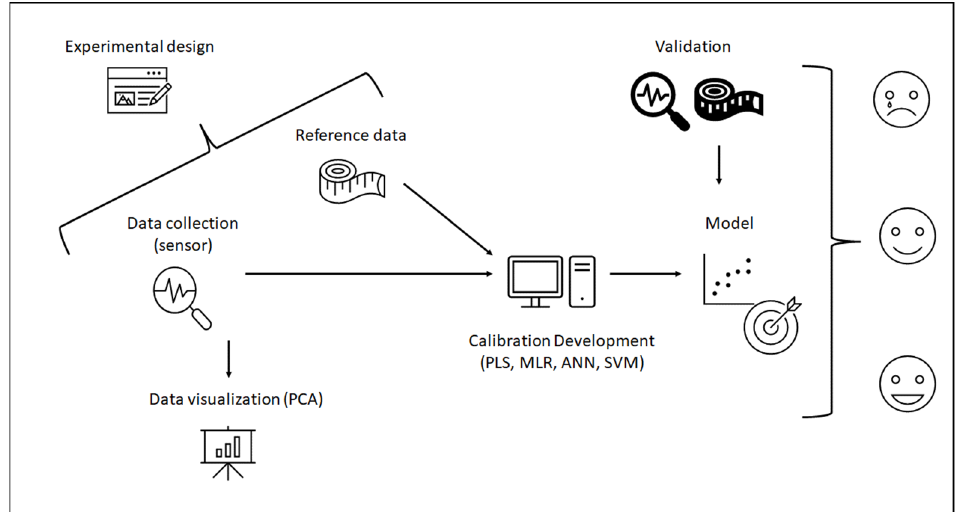
Figure 2. Calibration and validation steps in a nutshell.